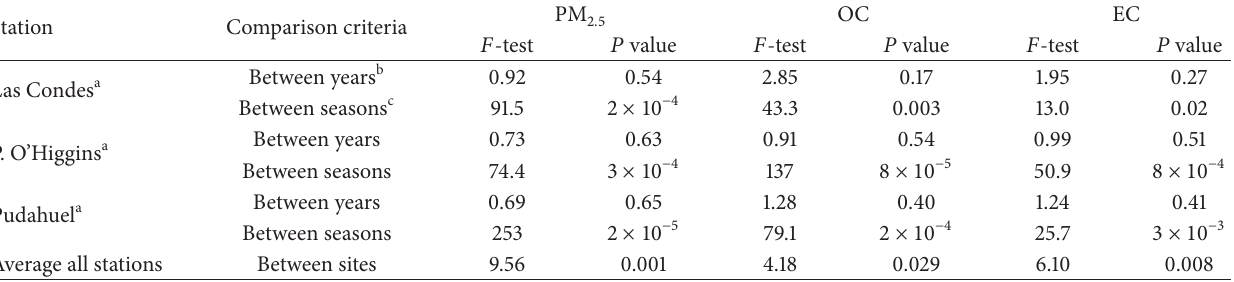
a Label of the stations in Figure 1. Las Condes: C Label, P. O’Higgins: O Label, and Pudahuel: P Label. b From 2002 to 2007. c Between cool and warm